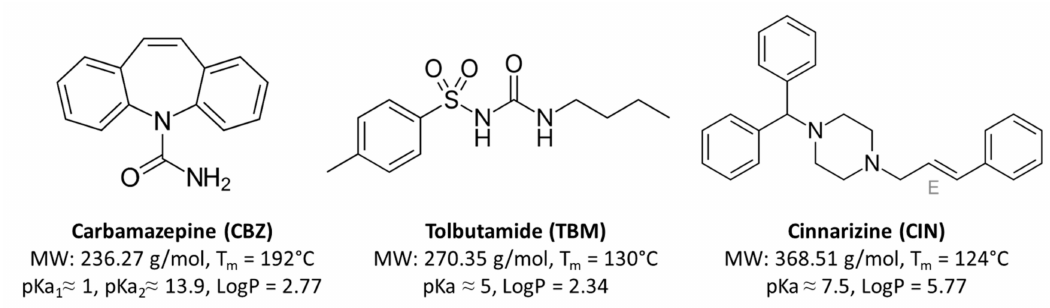
Figure 1. Molecular structures of model compounds and key physicochemical parameters.